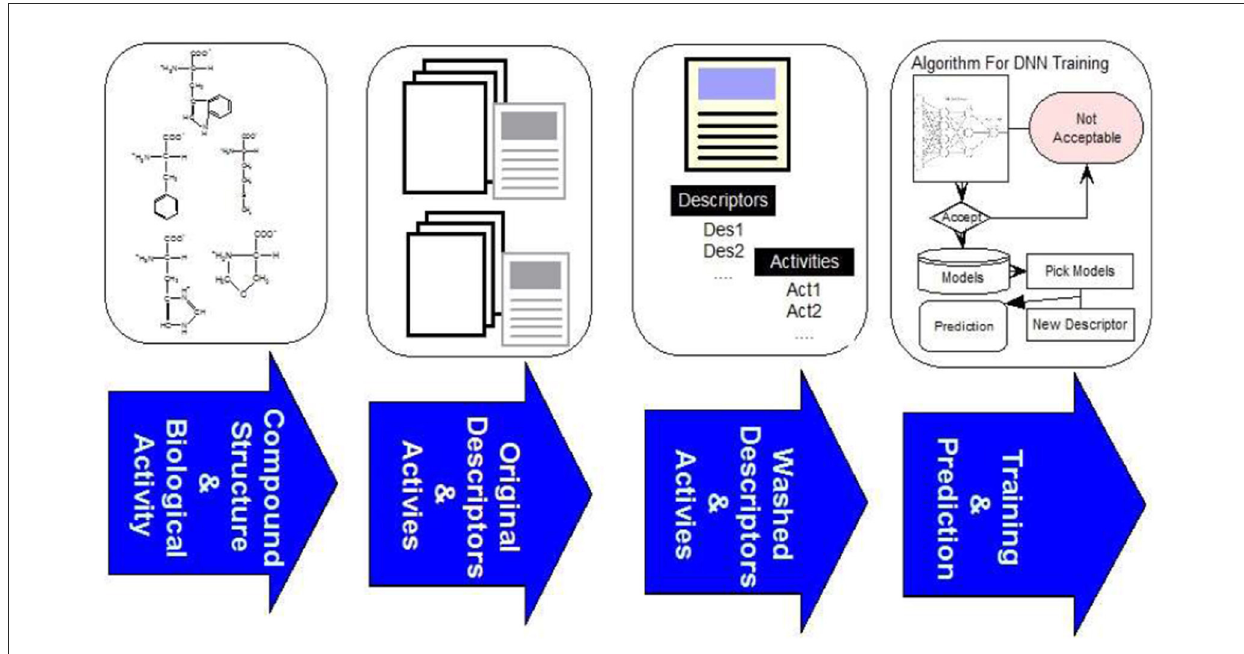
FIGURE2 The overall framework of JavaDL including data processing and DNN